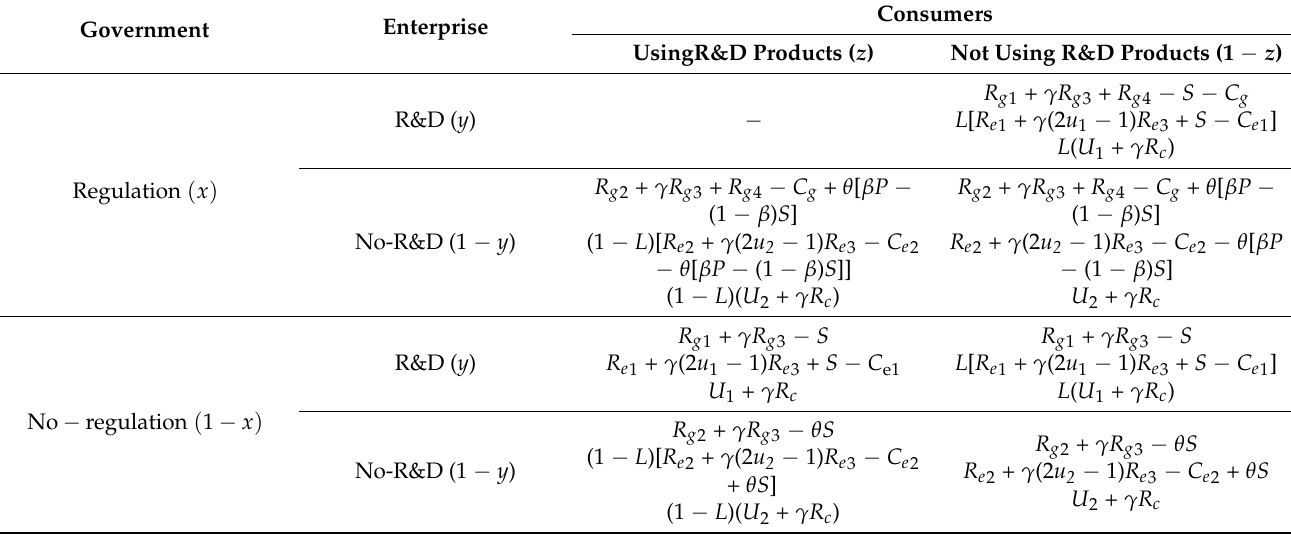
Table 7. Government–enterprise–consumer revenue